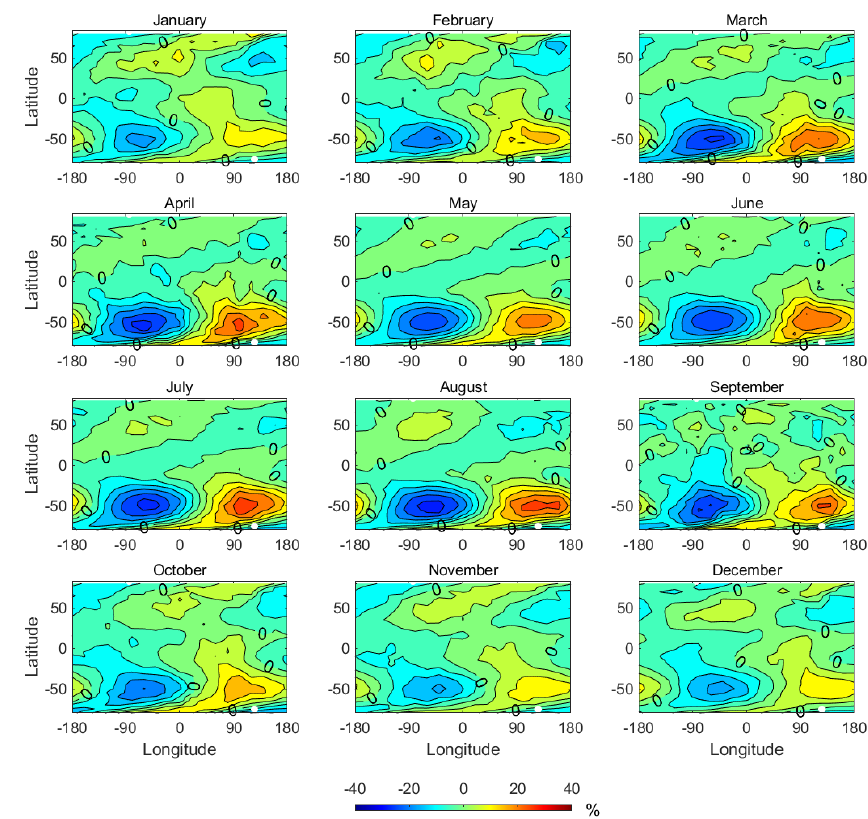
Figure 6. Same as Figure 2, except for the MSIS 2.0 model predictions.